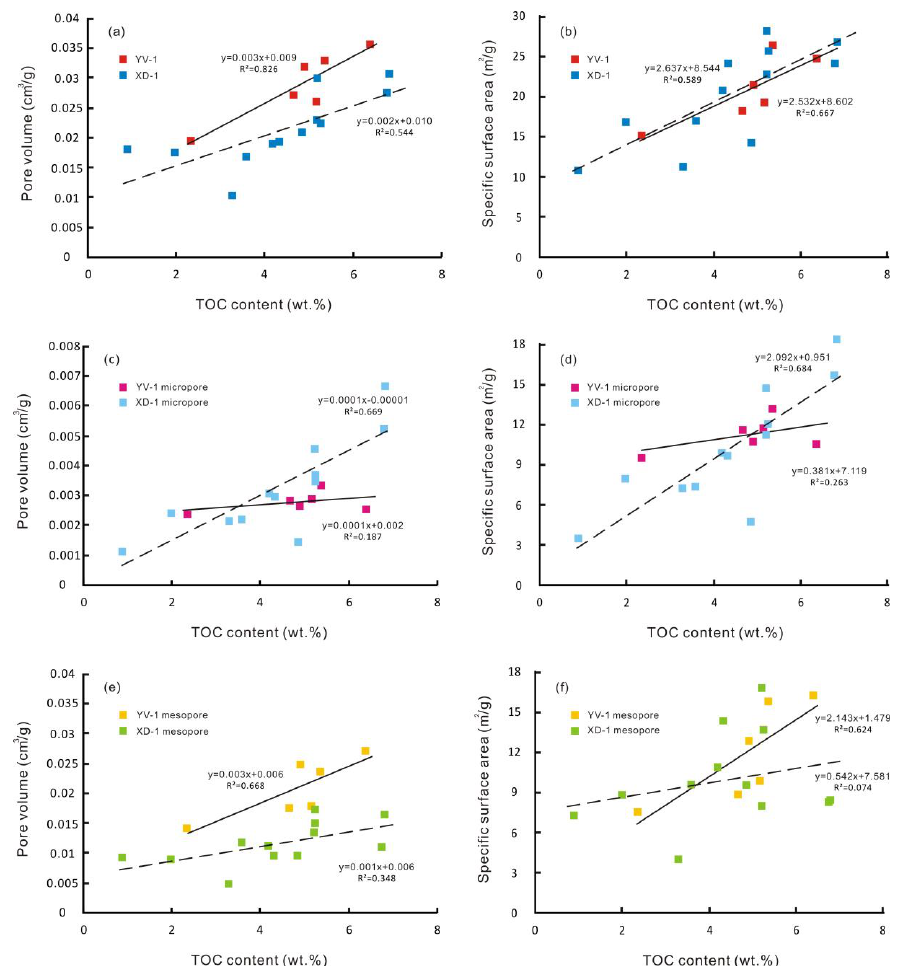
Figure 14. Relationships between TOC content and PV ( a ), SSA ( b ), micro-PV ( c ), micro-SSA ( d ), meso-PV ( e ), meso-SSA ( f ) of transitional Longtan Shale samples from YV-1 and